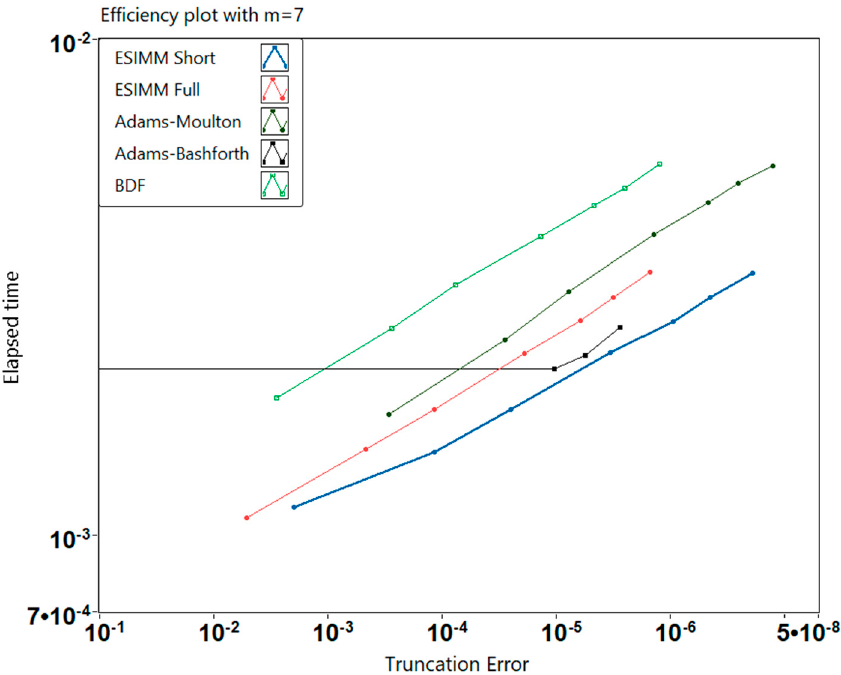
Figure 7. The performance plots for the van der Pol system with m = 7 obtained for investigated multistep integration methods of order 6. The stability loss on larger stepsizes can be observed for the explicit Adams–Bashforth method.